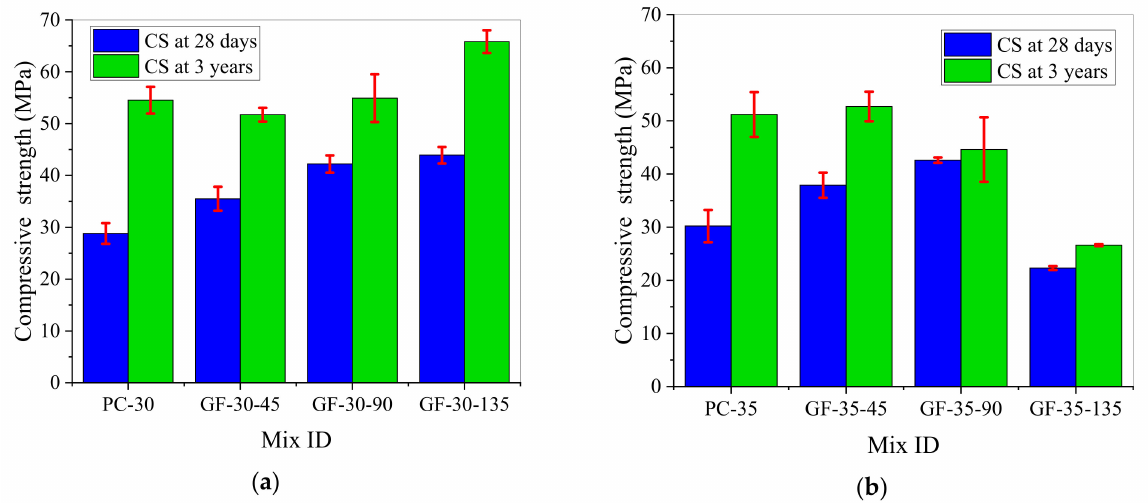
Figure 4. The 28-day and three-year compressive strengths of the GFRC: ( a ) w/b = 0.30; ( b ) w/b = 0.35.